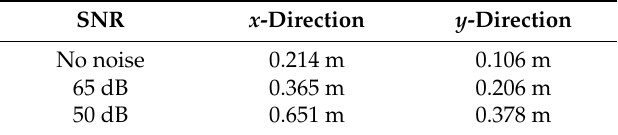
Table 1. Standard deviation of the robot’s position in the x - and y -directions.